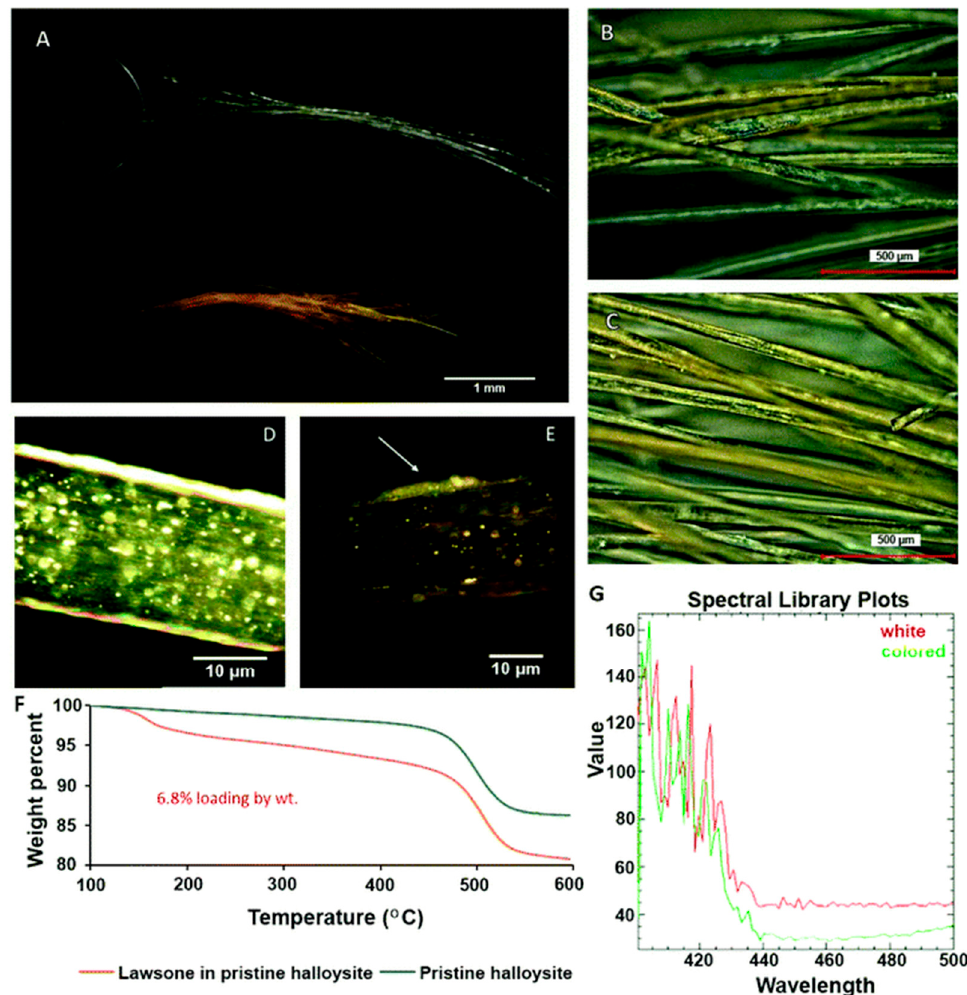
Figure 3. Color treatment of hair via halloysite self-assembly: grey hair (upper image, A ) washed for 3 min and treated with an aqueous dispersion of lawsone-loaded halloysite gives a bright orange color (bottom image, A ). High definition images of hair coated with brown lawsone loaded halloysite ( B , C ). Dark field images of intact grey ( D ) and colored grey ( E ) hair from the same person (note the color change and the visible halloysite-dye aggregate indicated by the arrow); reflected light spectra recorded in transmission dark field microscopy mode demonstrating the color change in grey hair after dye-halloysite composite deposition onto hair ( G ). Thermogravimetric analysis (TGA) results of lawsone-loaded halloysite tubes. ( F ) shows their increased weight loss against pristine halloysites referring to the incineration of organic dye content.